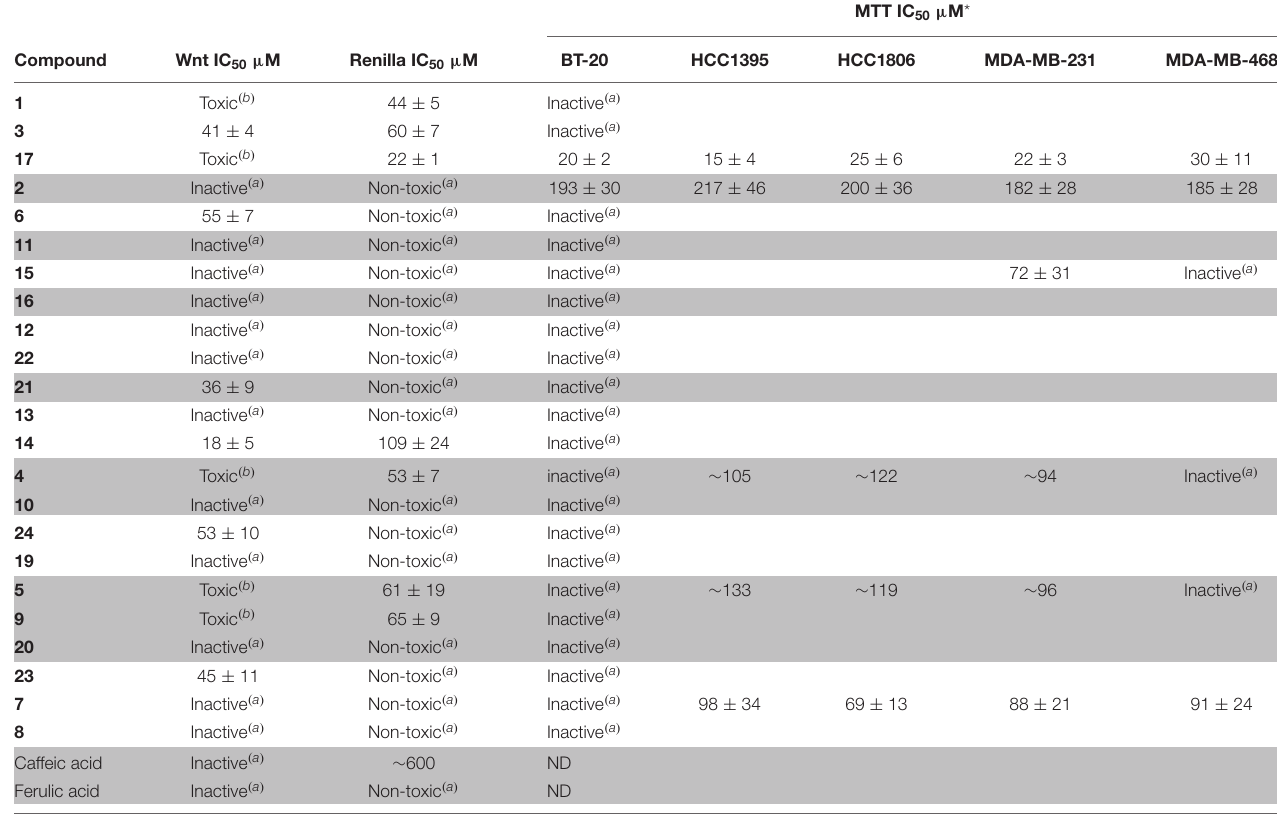
TABLE 1 | Inhibition of the Wnt pathway with the biotransformation